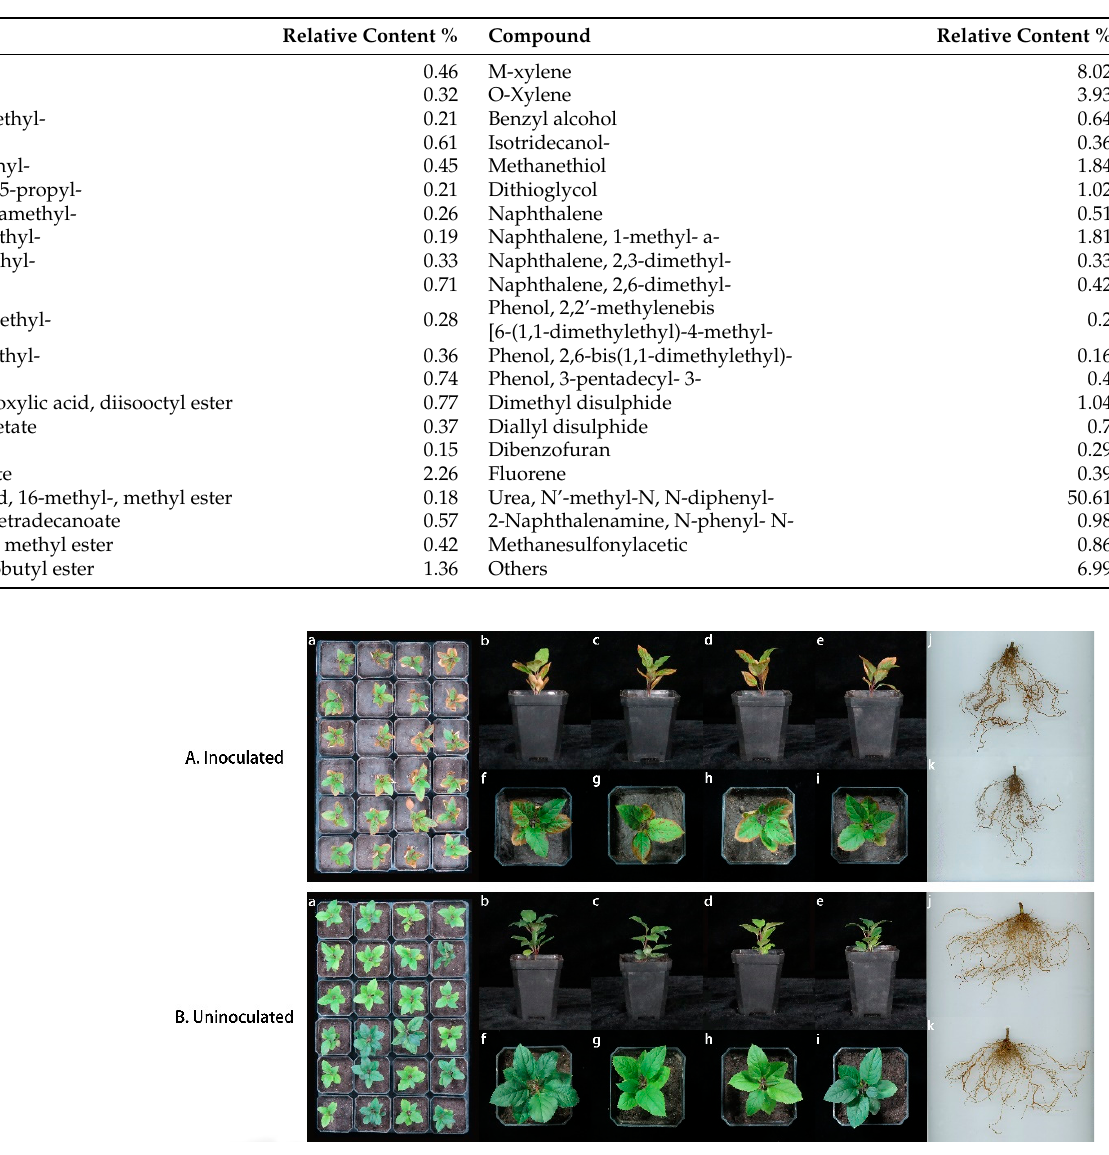
Table 2. Effect of mixed cropping with A. fistulosum L. on the biomass of the grafted apple seed ‐